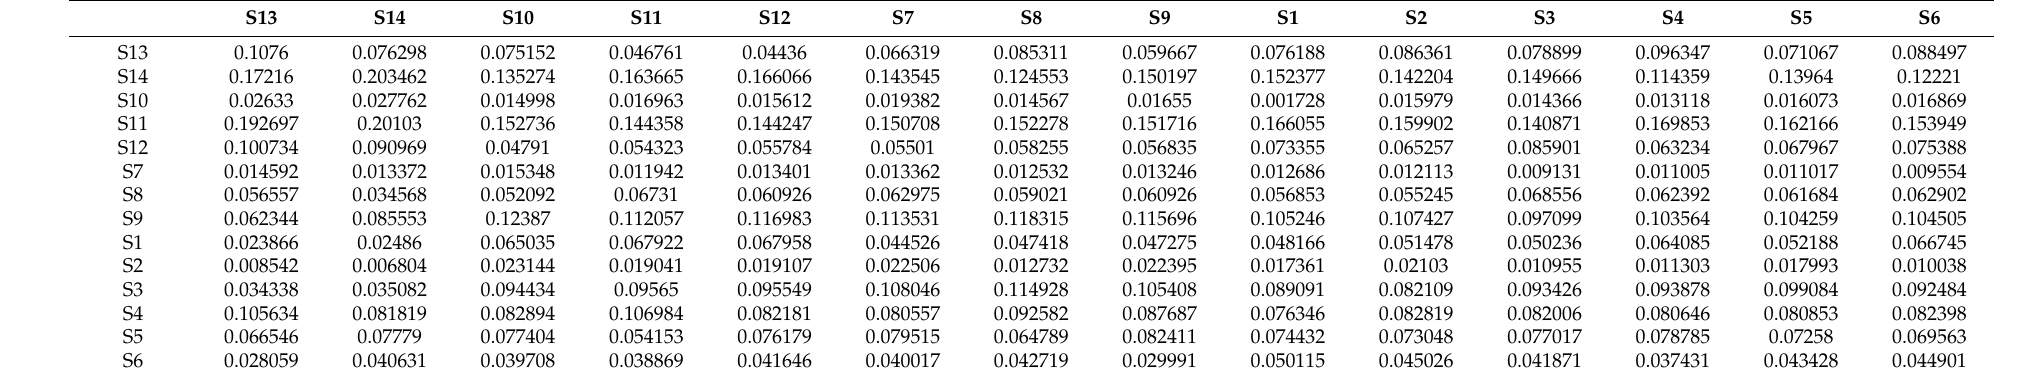
Table A2. Weighted supermatrix for compatibility before the convergence of